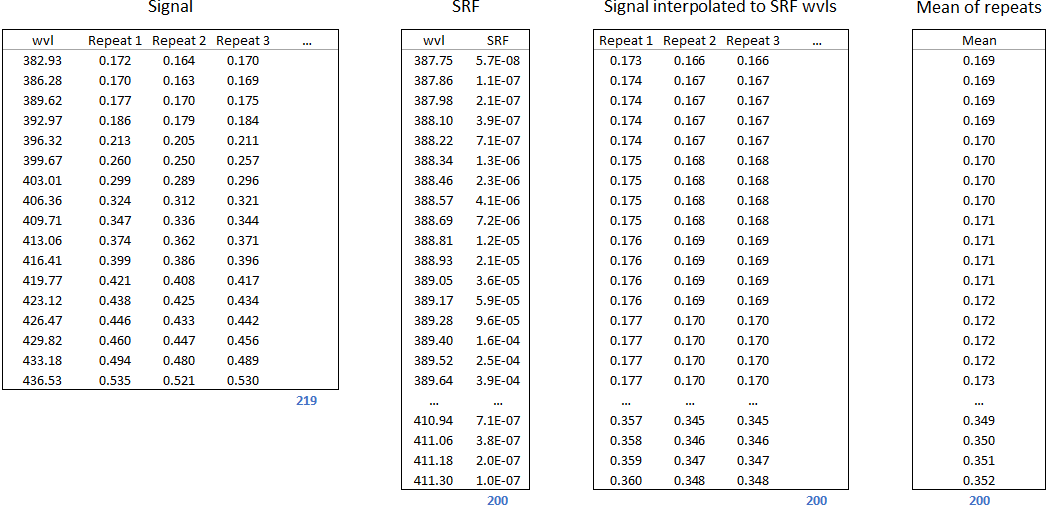
Figure 4. Description aid for the process of interpolating the signal values to the SRF values and finding the mean of the repeats. Note that this is for one band only; each band will have its own set of tables. The blue number below each table shows how many rows that table